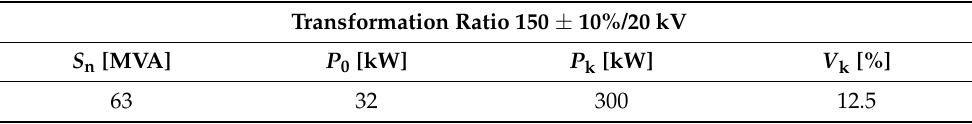
Table 6. Electrical data of the HV/MV transformers.